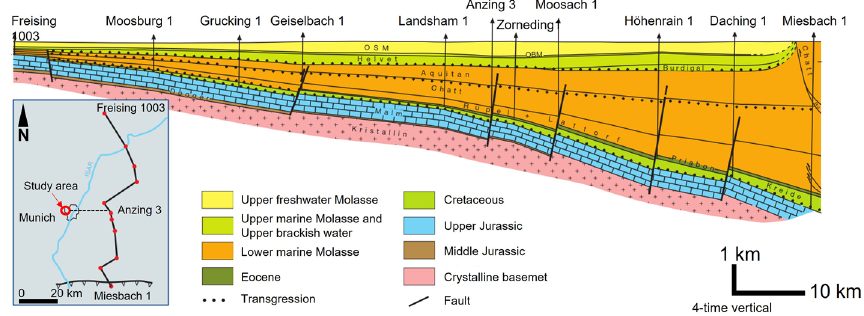
Fig. 3 N–S cross-section of the Molasse basin (Lemke 1988). It shows the asymmetric geometry of a typical foreland basin that is dipping to the South towards the Alps. The geothermal reservoirs of the Upper Jurassic carbonates (blue) are therefore buried deep enough in the greater Munich area to reach attractive temperatures for heat and further south even for combined heat and power